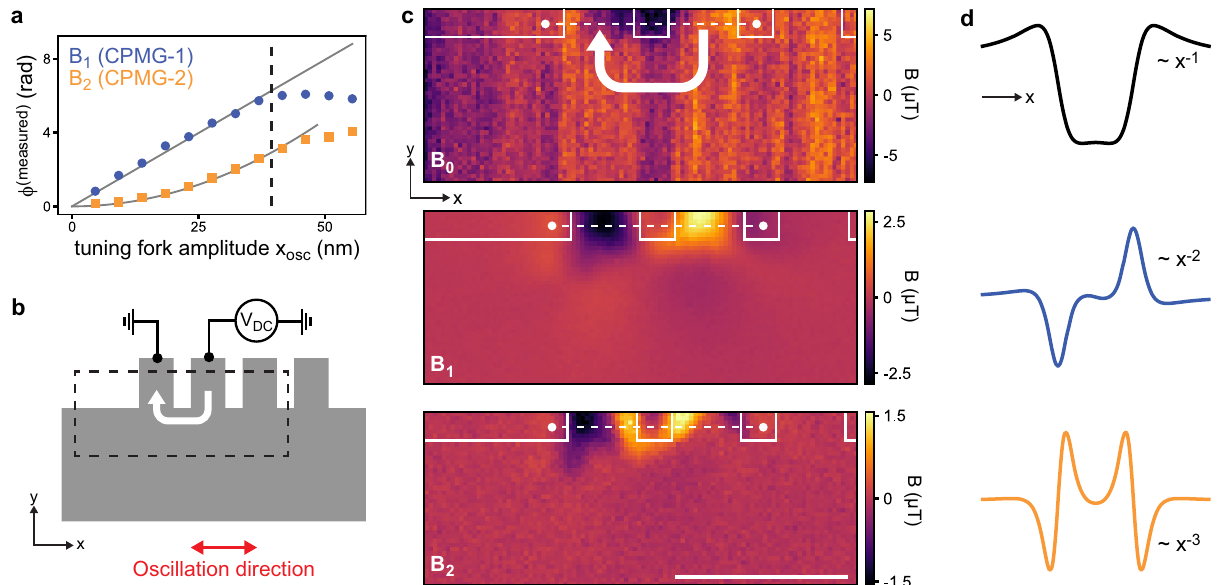
Fig. 3 Two-dimensional scanning gradiometry of current fl ow in a graphene test geometry. a Measured and unwrapped quantum phase ϕ (measured) plotted as a function of tip oscillation amplitude x osc for the fi rst (blue) and second (orange) harmonic. Solid lines are ∝ x osc and / x 2 dashed line indicates maximum oscillation amplitude before the Taylor approximation breaks down due to the onset of spatial averaging. b Schematic of the bilayer graphene device (gray). A direct current of I dc ≈ 5.3 μ A (white arrow) is applied between the indicated contacts (width ~400nm). c , Static fi eld map B 0 , gradient map B 1 , second derivative map B 2 from the area indicated in b . Contours re fl ect the device layout. Dwell time is 30 s per pixel. Scale bar, 1 μ m. d , Analytical spatial pro fi les for the z component of the magnetic fi eld, gradient, and second derivative generated across the two contacts (dotted lines in c ). The far- fi eld decay with x is also